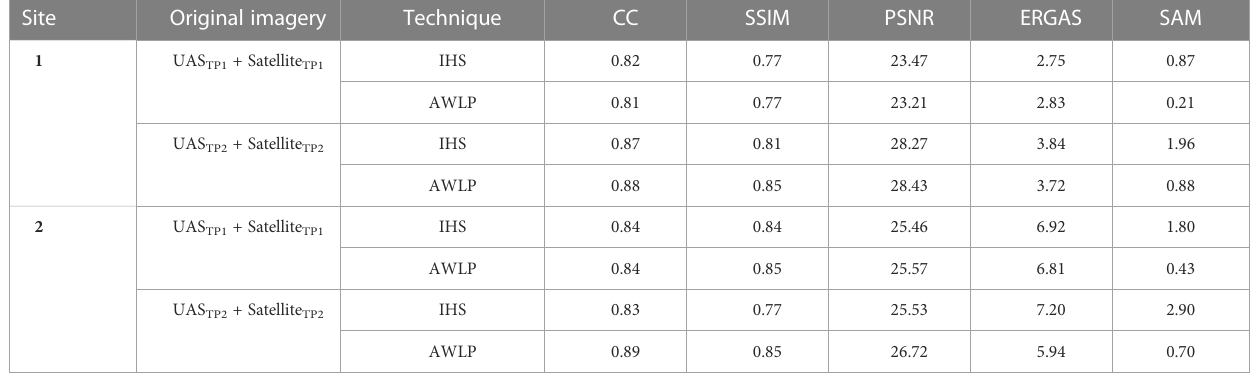
TABLE 3 Image comparison metrics correlation coef fi cient (CC), the structural similarity index measure (SSIM), the peak signal to noise ratio (PSNR), the erreur relative globale adimensionnelle de synthese (ERGAS), and the spectral angle mapper (SAM) comparing different pan-sharpened imagery (GSD = 0.02-0.03 cm/pixel) generated using intensity-hue-saturation (IHS) and additive wavelet luminance proportional (AWLP) approaches with original satellite